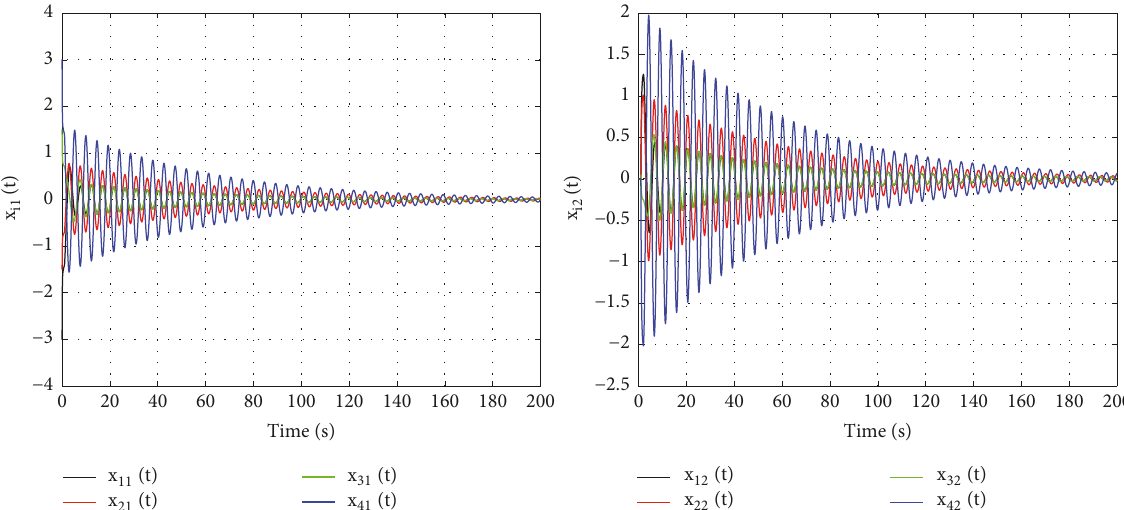
Figure 2: The trajectories of all agents’ states in the FOMAS with double integral and symmetric time-delays when all 𝜏 𝑚 < 𝜏 in Example 1.